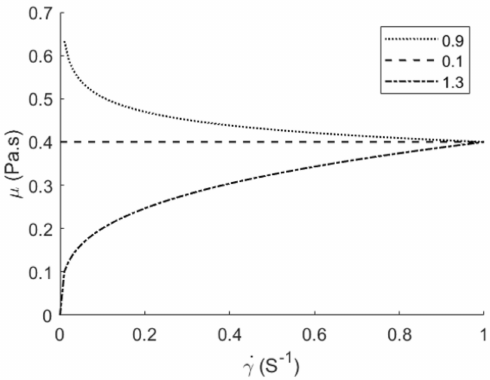
Figure 3. Viscosity changes versus shear rates in power-law fluids for different n ( λ =